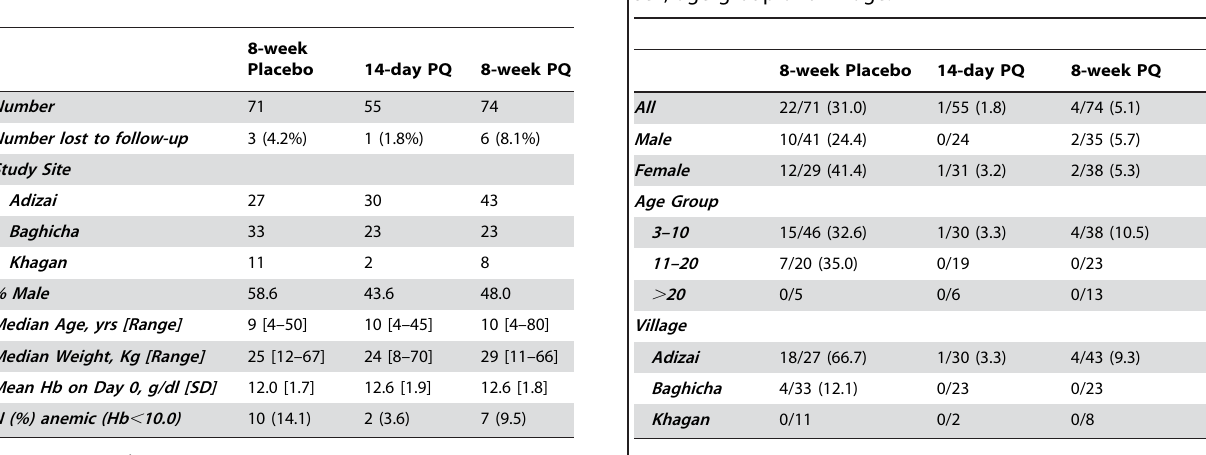
Table 1. Enrolment characteristics of study sample, by treatment group.